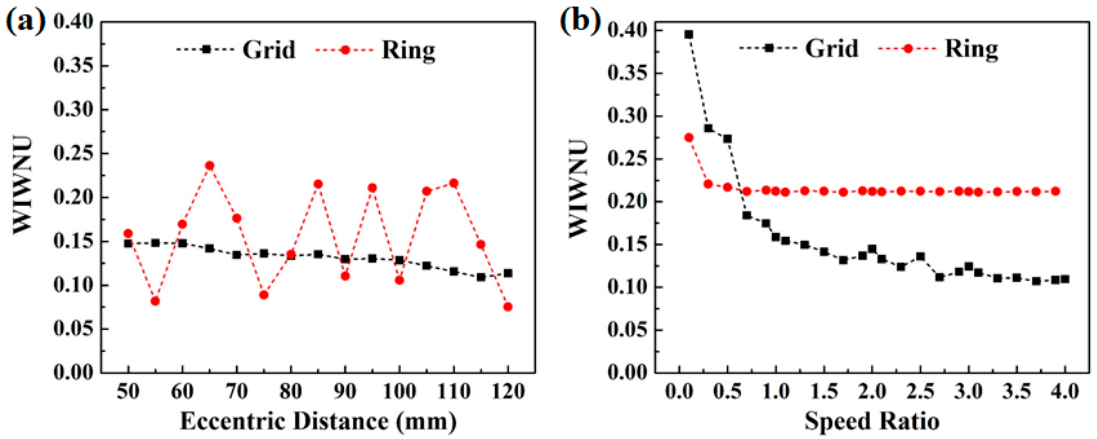
Figure 4. Plot of the non-uniformity coefficient of trajectory against ( a ) eccentric distance and ( b ) transmission ratio.